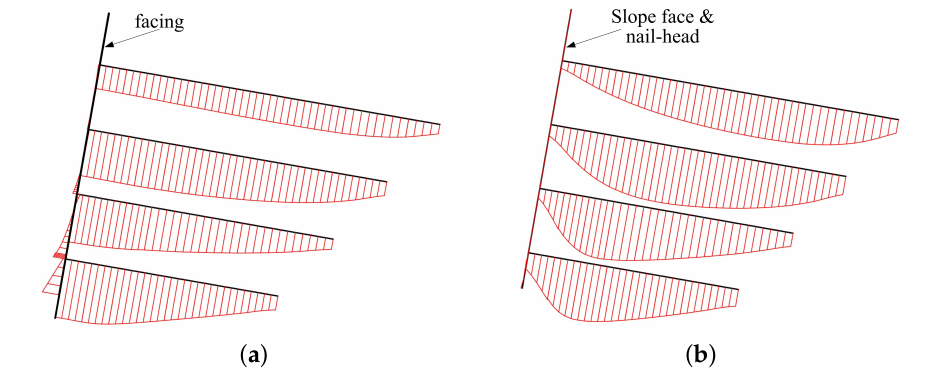
Figure 9. Distribution of nails axial force with excavated face covers by: ( a ) full-face facing; ( b ) nail